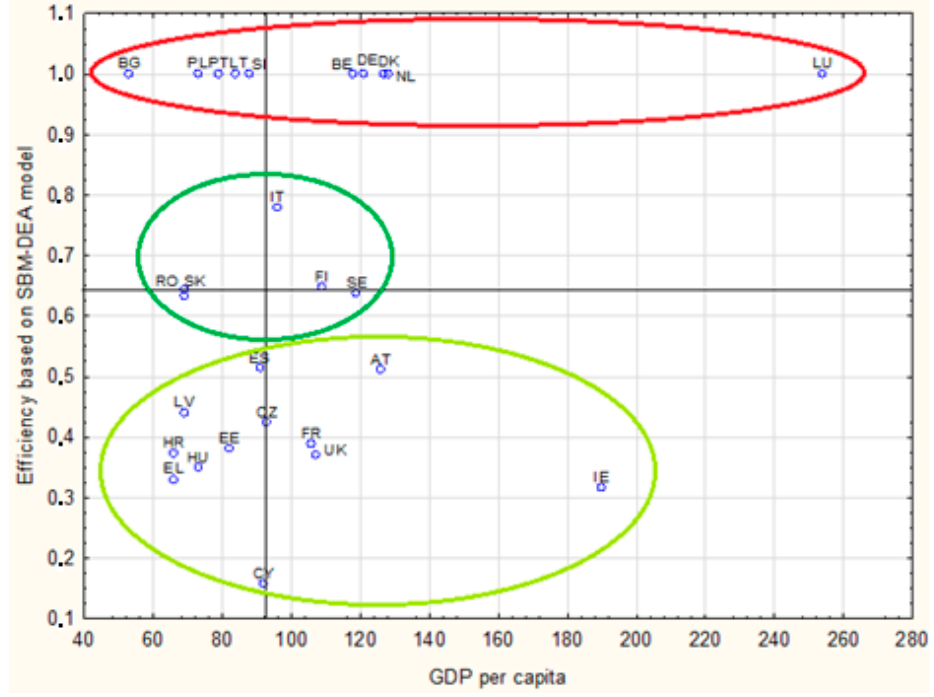
Figure 13. Eco-efficiency of road freight transport sector in EU countries versus GDP per capita . Source: Own elaboration.